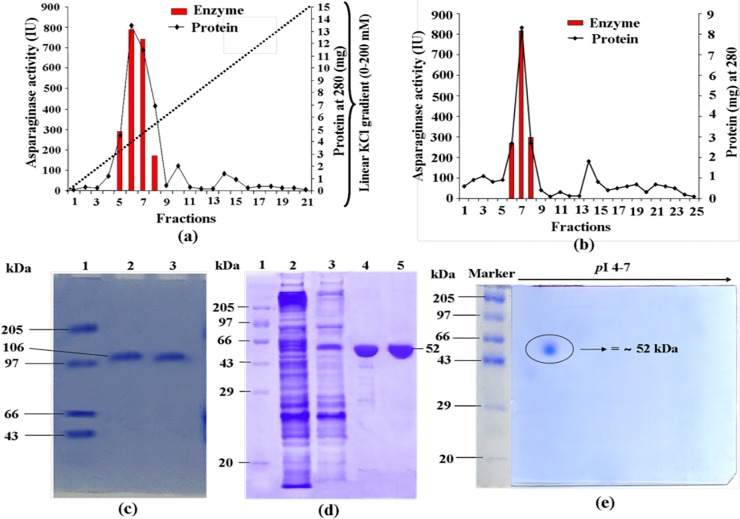
Purification of asparaginase from E. cloacae.Elution profiles of asparaginase (a) Cation exchange chromatography of 60–90% ammonium sulphate precipitated fraction on DEAE-cellulose column (2×15 cm2, Sigma). The column was pre-equilibrated with 0.05 M Tris-HCl buffer (pH 9.6) and absorbed protein was eluted with a linear gradient of KCl (0–200 mM) prepared in 0.05 M Tris-HCl buffer (pH 8.6). (b) Gel filtration of fractions (5,6,7 and 8) from DEAE-cellulose column on a Sephadex G-100 column (2×20 cm2, Sigma), which was pre-equilibrated with 0.05 M Tris-HCl buffer (pH 8.6) and eluted with the same buffer at a flow rate of 0.2 ml min-1. (c) Assessment of homogeneity and molecular weight analysis of purified asparaginase on Native-PAGE, Lane 1- Protein marker; Lane 2 and 3- Sephadex G-100 purified asparaginase. (d) SDS-PAGE, Lane 1- Protein marker; Lane 2- Cell free crude asparaginase; Lane 3- Ammonium sulphate precipitated asparaginase; Lane 4-DEAE-cellulose purified asparaginase and Lane5- Sephadex G-100 purified asparaginase. (e) Two-dimensional electrophoretic resolution of purified asparaginase. Purified enzyme (30 μg) after resolved by IEF and SDS-PAGE gel was visualized by coomassie brilliant blue staining. Molecular weight was calculated with standard molecular weight markers.